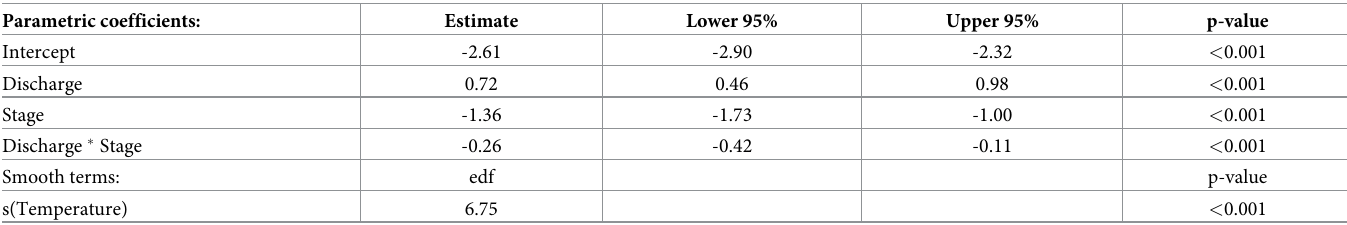
Table 2. Estimates and 95% confidence intervals for parametric coefficients and estimated degrees of freedom (edf) for smooth terms for a generalized additive model (GAM) of grass carp Ctenopharyngodon idella spawning migration behavior on the Osage River above Truman Reservoir, Missouri, 2019. Parametric